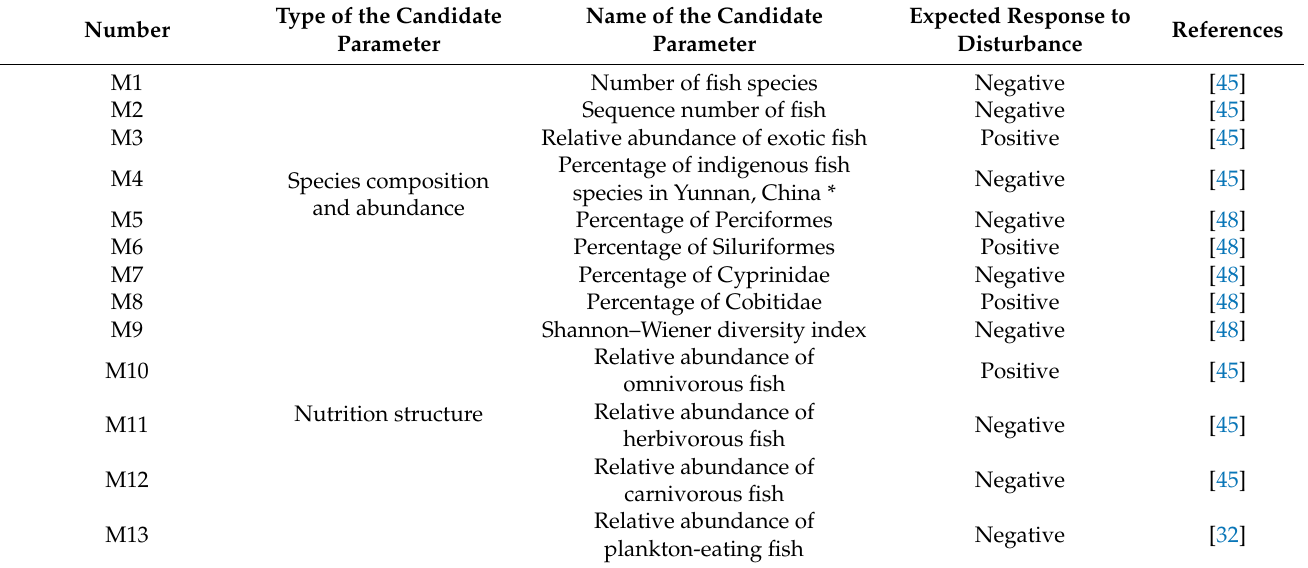
Table 1. Candidate indices for F-IBI and their expected responses to environmental stresses in Dianchi Lake and the three inflowing